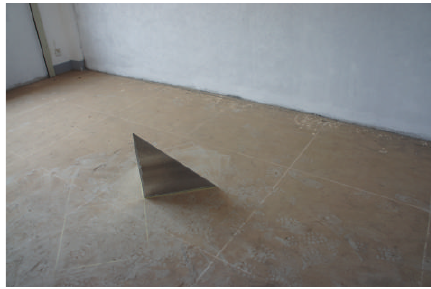
Figure 20: In the static target experiment, a trihedral is used as the target and placed 2m behind the wall.